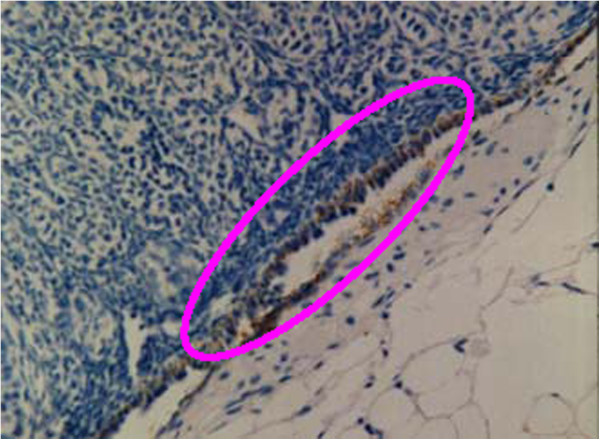
Little amount of metastasis of ovarian cancer cells in contralateral ovary. Immunohistochemical staining test CA125 × 200.